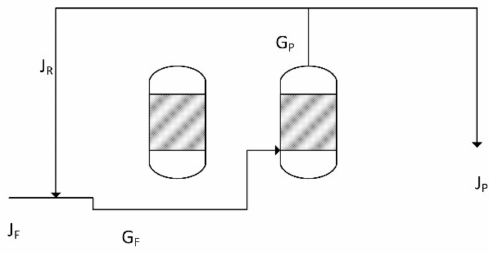
Figure 25. Summary of the reactor recycle process flow. Two reactors are shown, a Halite Reactor and a ZVI Reactor. The product gas from the ZVI Reactor is recycled.